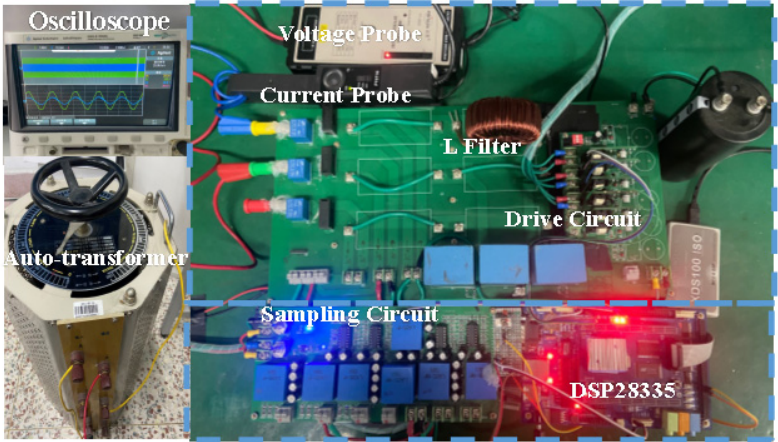
Figure 4. Flowchart for the execution process of the designed DRFNNISMC strategy.